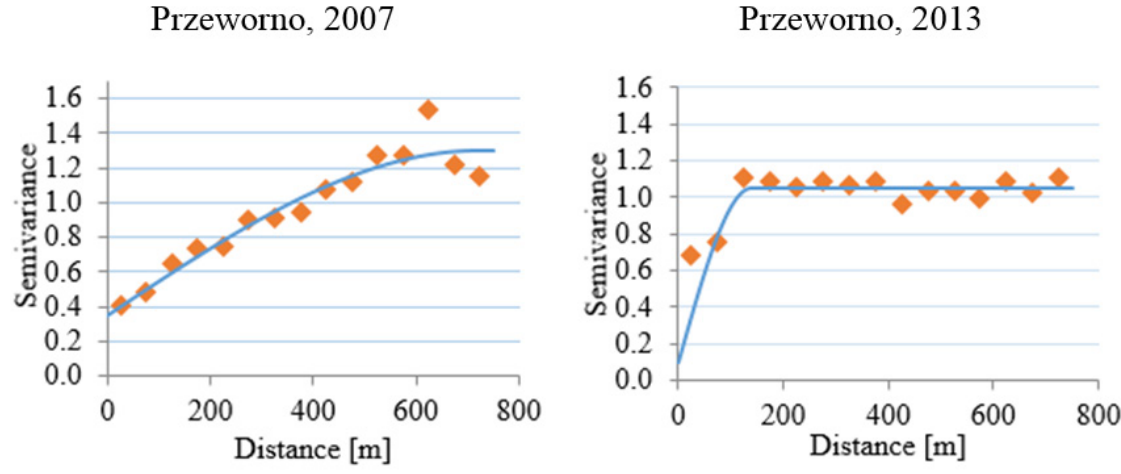
Figure 8: Semivariogram of the K contents in Przeworno (light soils) at the beginning (2007) and at the end of the experiment